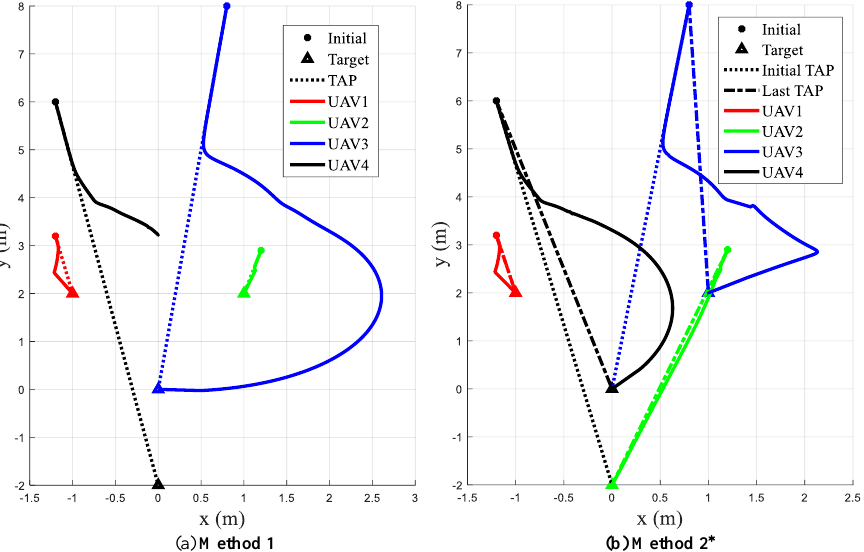
Figure 13. Trajectories of three UAVs planned by Method 1 and Method 2*